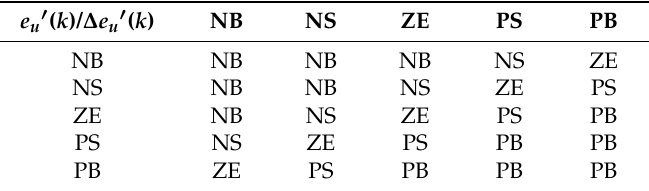
Table 1. Fuzzy control rules.